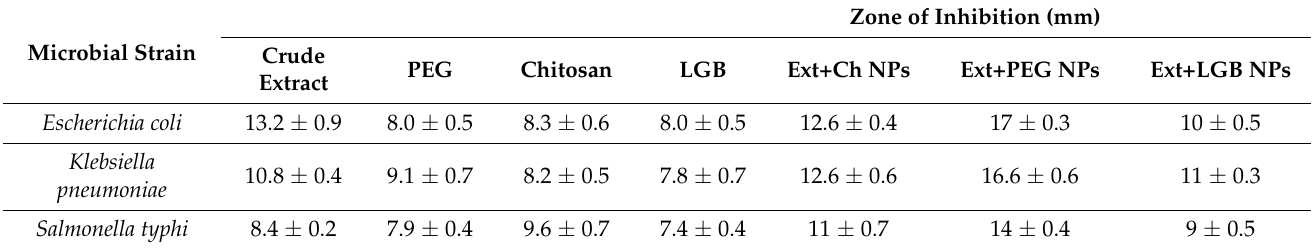
Table 4. Antibacterial potential of crude extract of Indigofera linifolia , polymers (PEG, chitosan,